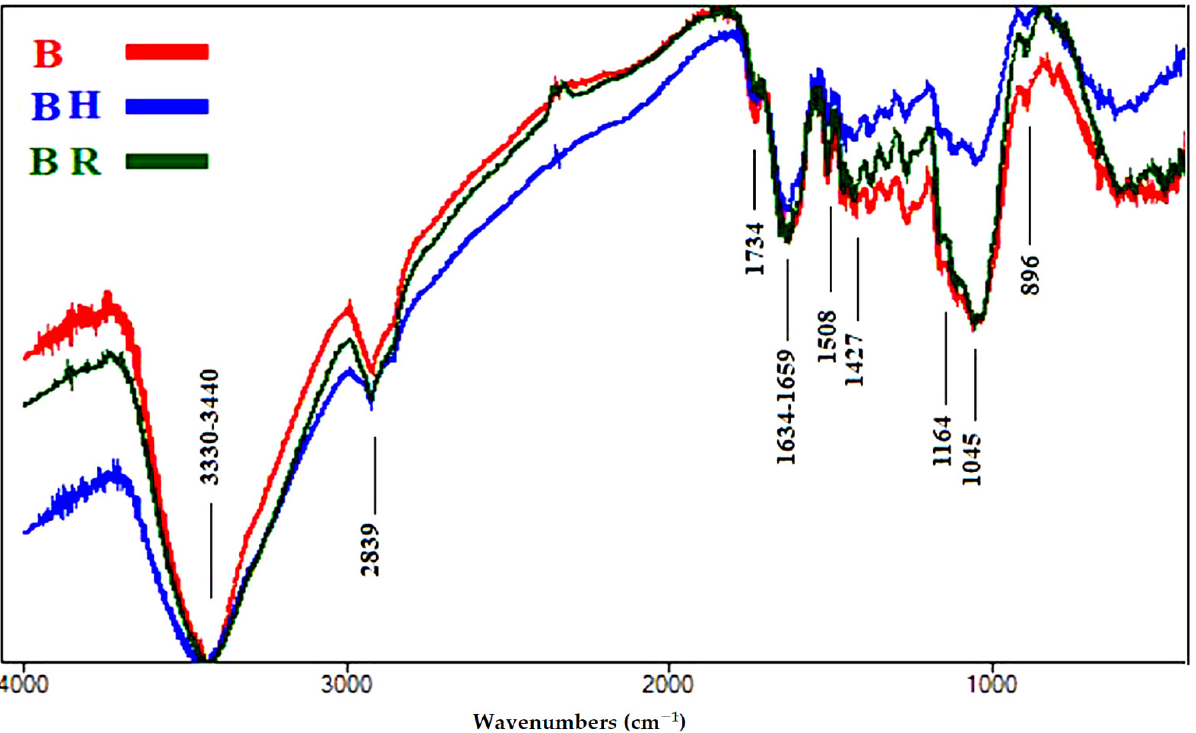
Figure 4. FTIR spectra of the wood samples of Schinus terebinthifolius (A, control; AH, heated ageing; AR, rusted ageing).